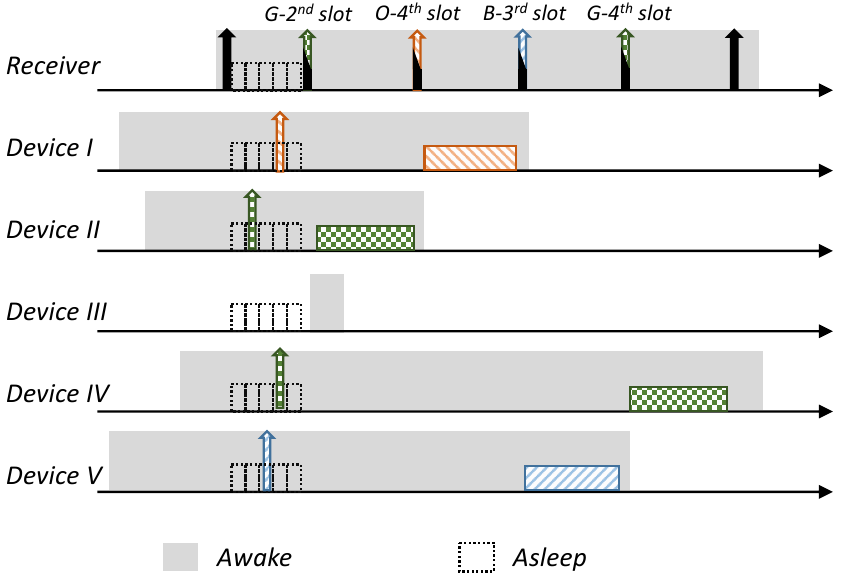
Figure 5. Reuse of CSSs by multiple devices in the vacancy via a small contention interval. Device II and Device IV utilize the same CSS, yet choose different minislots; hence, they can be distinguished by the sink. Device I and Device IV choose the same minislot, yet utilize different CSSs; hence, they can also be distinguished by the